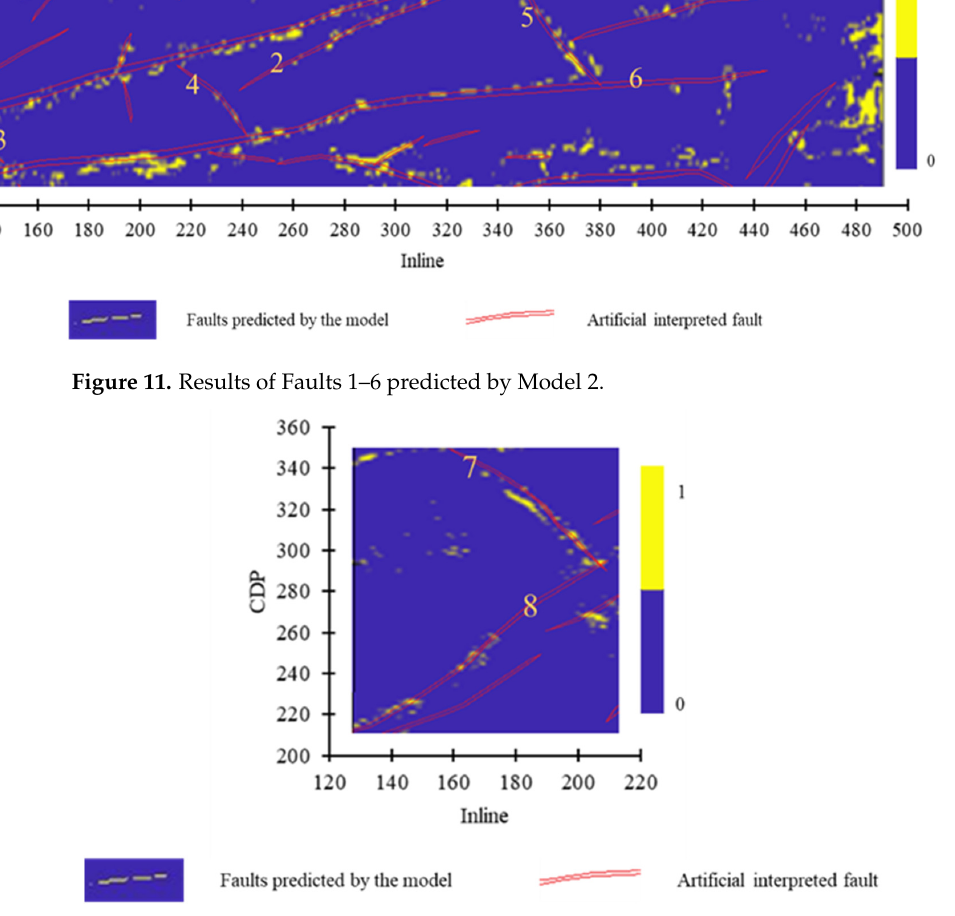
Figure 13. Result of Faults 1–6 predicted by Model 3.